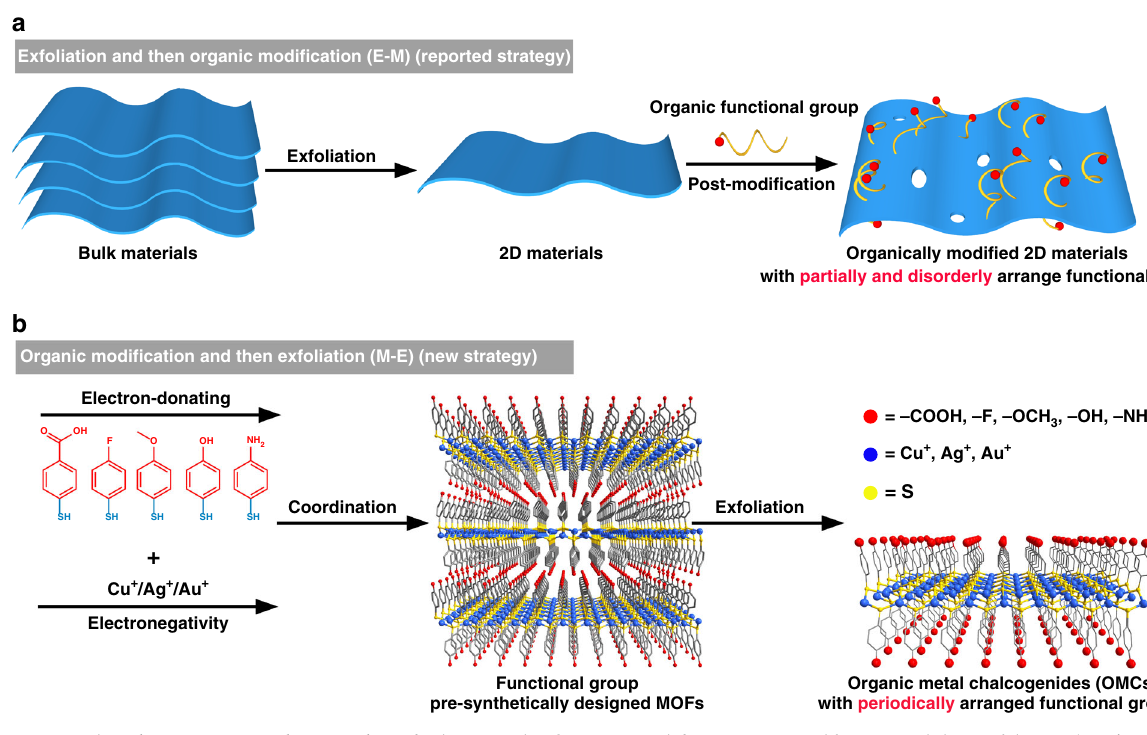
Fig. 1 Comparison between new and reported synthetic strategies for 2D materials. a organic modi fi cation and then exfoliation ( M – E ) strategy for OMCs; b exfoliation and then organic modi fi cation ( E – M ) strategy for the known 2D